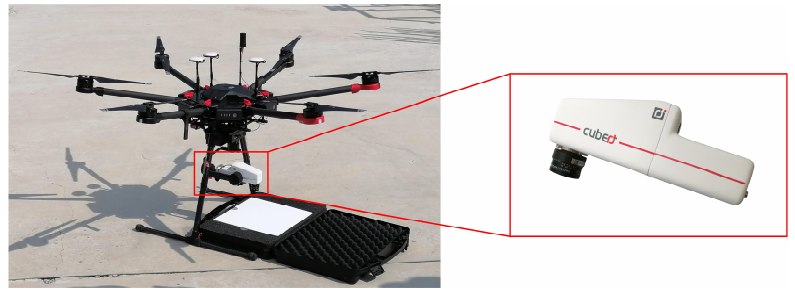
Figure 2. DJI-M600PRO UAV and Cubert-S185 hyperspectral sensor.